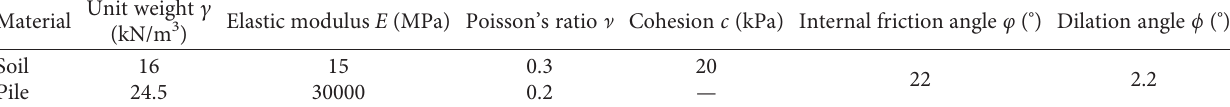
Table 1: Model material parameters.